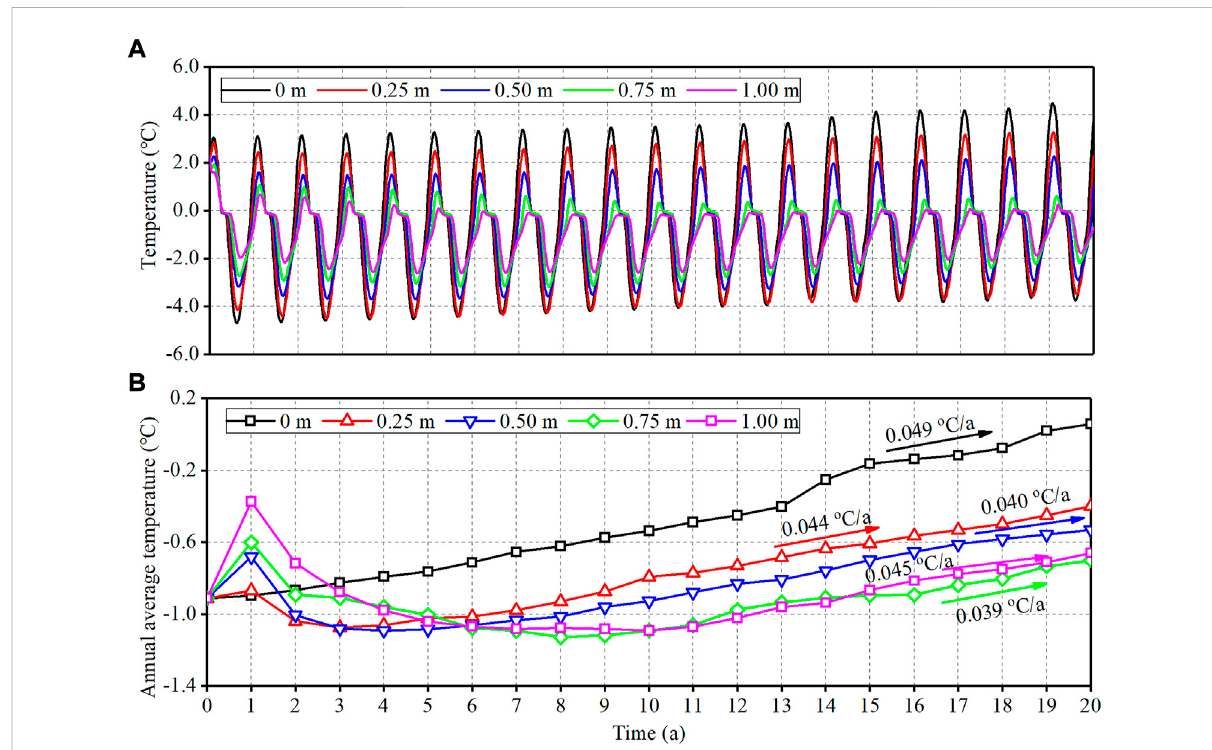
FIGURE 6 Variation of the soil temperature at − 1.00 m under ground surface during 20 years (A) the temperature, (B) the annual average temperature.